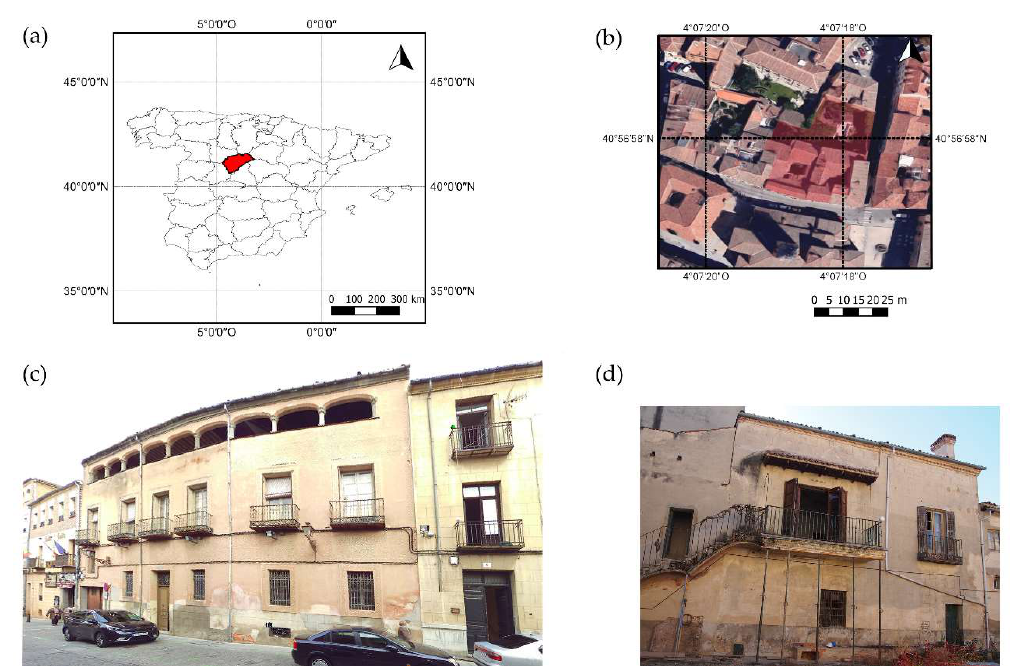
Figure 4. ( a ) Location of the province of Segovia; ( b ) the palace in Segovia; ( c ) main front facade of the palace; ( d ) back front facade of the palace.